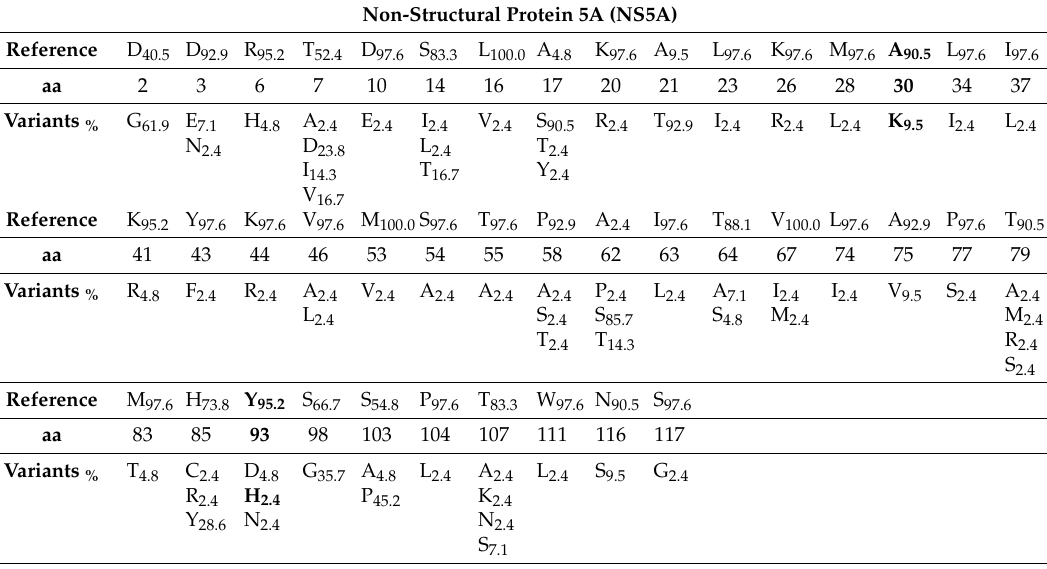
Table 3. Amino acid (aa) substitutions detected at baseline by Sanger sequencing in non-structural protein 5A (NS5A) and non-structural protein 5B (NS5B) from 42 patients for whom sequence data are available. Substitutions that differed from the reference sequence (D17763) are reported. The numbers in subscript text next to the amino acid substitution represent the frequency of each polymorphism. Substitutions known to reduce susceptibility to DAAs in HCV GT3a patients are shown in